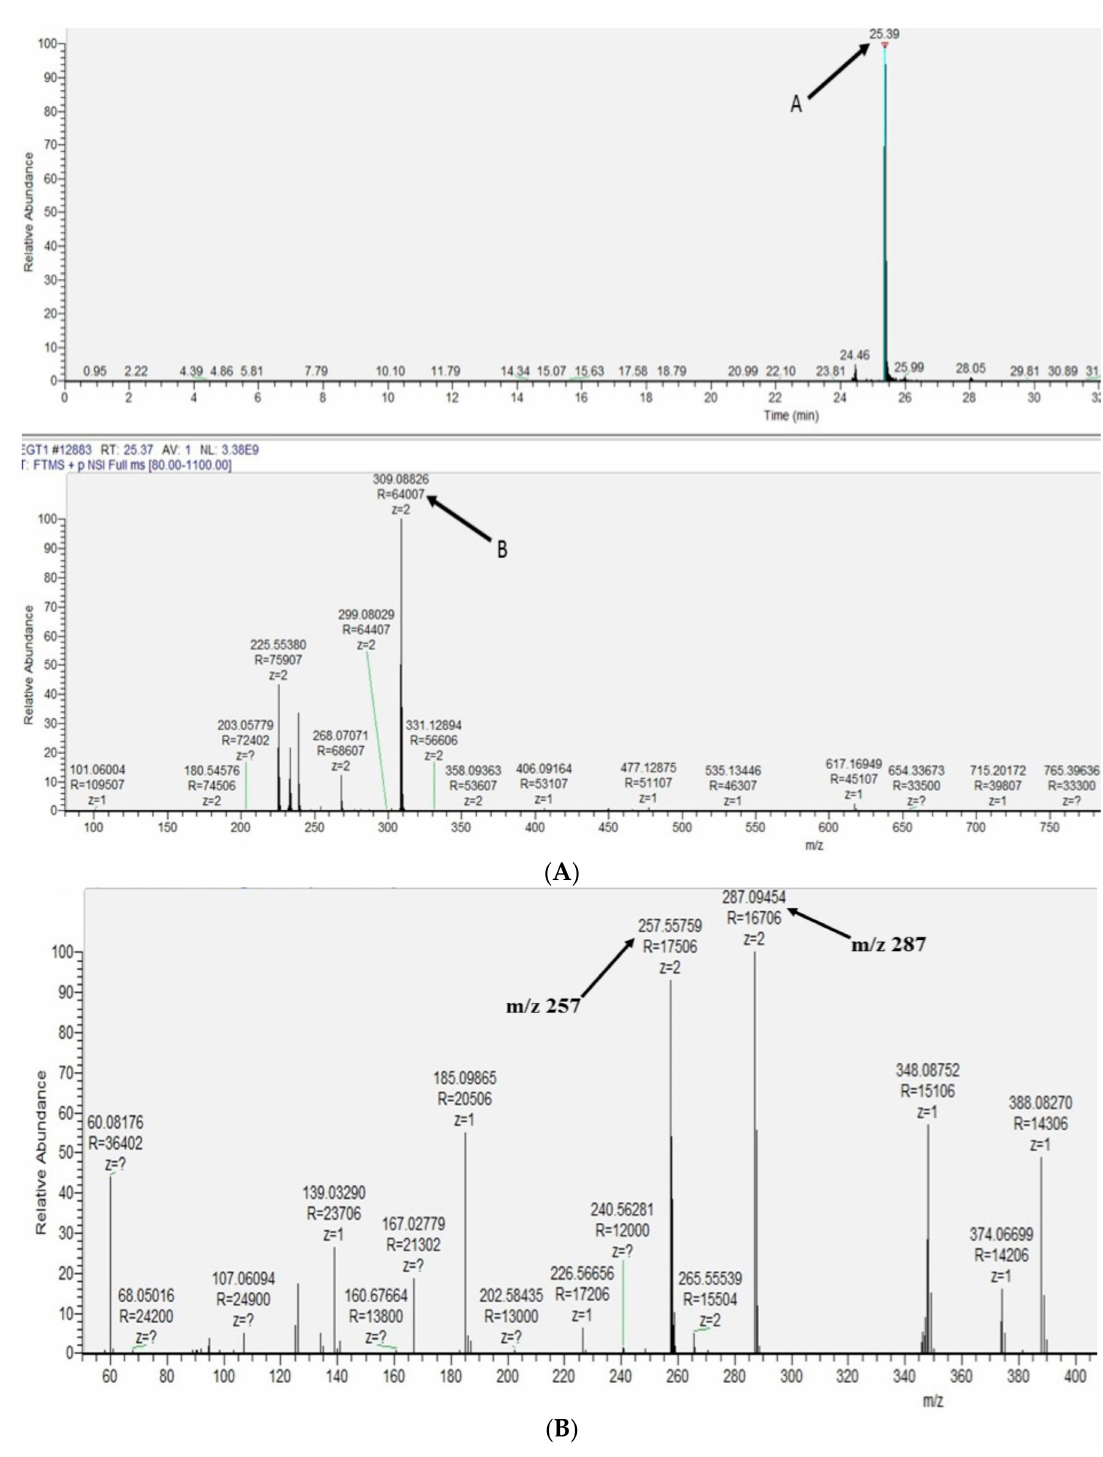
Figure 3. ( A ) The double protonated form of alkylated EGT (M + H) 2+ = m/z 309 was identified in BY4741 egtA culture supernatant at retention time of 25.39 min (A); ( B ) MS 2 of m/z 309 yielded the expected daughter ions of m/z 309 ( B ), confirming extracellular alkylated EGT presence. 2.4. Detection of Mainly Extracellular Ergothioneine from Recombinant S. cerevisiae–EgtA Using RP–HPLC